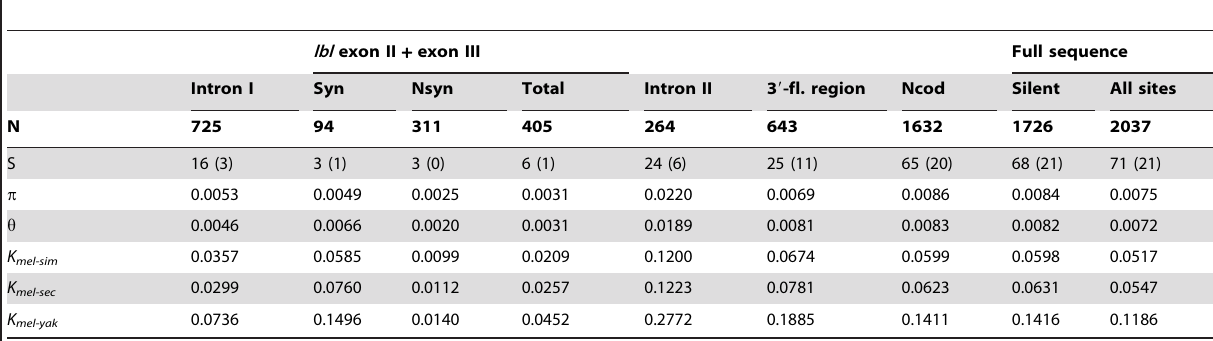
Table 2. Nucleotide diversity and divergence in the lbl gene region of D.